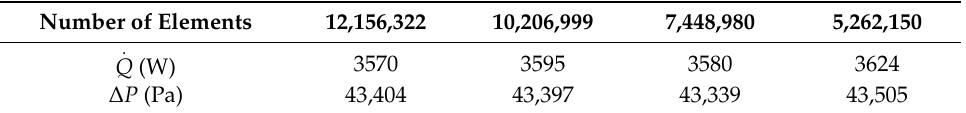
Table 4. Grid independence of flow and heat transfer [ h o = 250 W / (m 2 K),